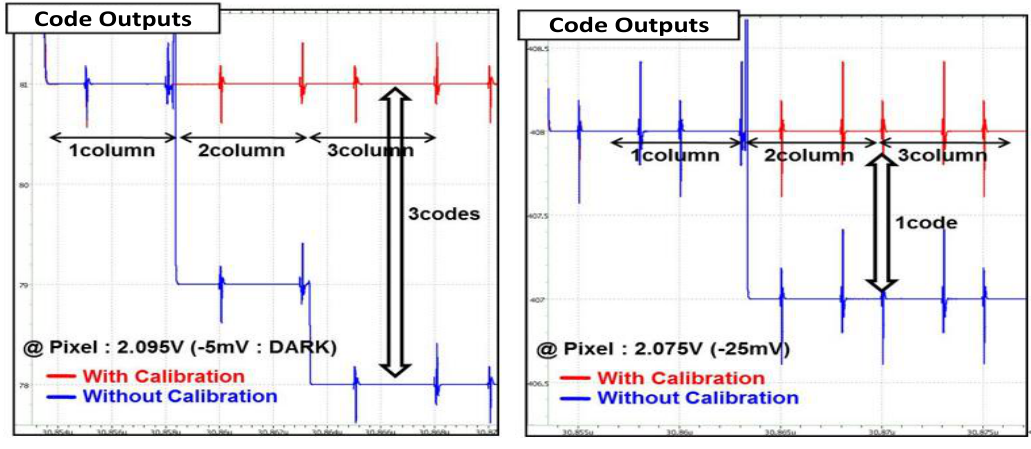
Figure 12. Simulation results for the self-calibration technique.